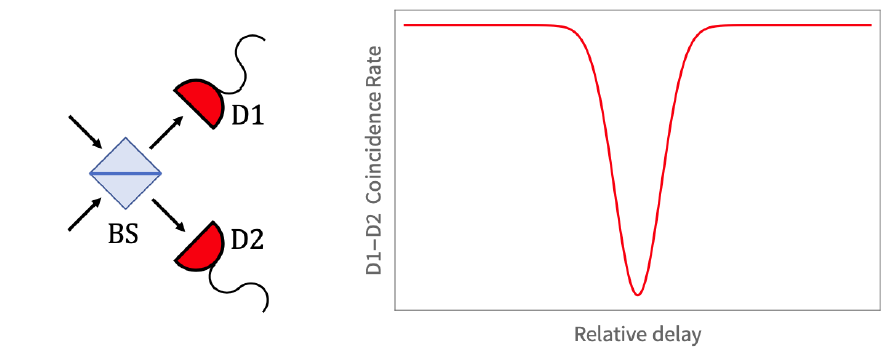
Figure 1. Schematic illustration of the Hong-Ou-Mandel (HOM) effect. Left: Two near-simultaneous photons with similar wavelength impinge on a beam splitter (BS), and the outputs are registered on two detectors, D1 and D2. When the photons’ arrival is simultaneous, making them indistinguishable, the HOM interference effect causes both photons to exit one side of the splitter or the other, inhibiting the outcome with one photon going to each detector. Right: The signature of the HOM effect is a drop in the rate of coincident detections at D1 and D2, as the photon arrival times become identical. This is typically observed as an “HOM dip” in coincidences as a function of some relative time delay at the BS